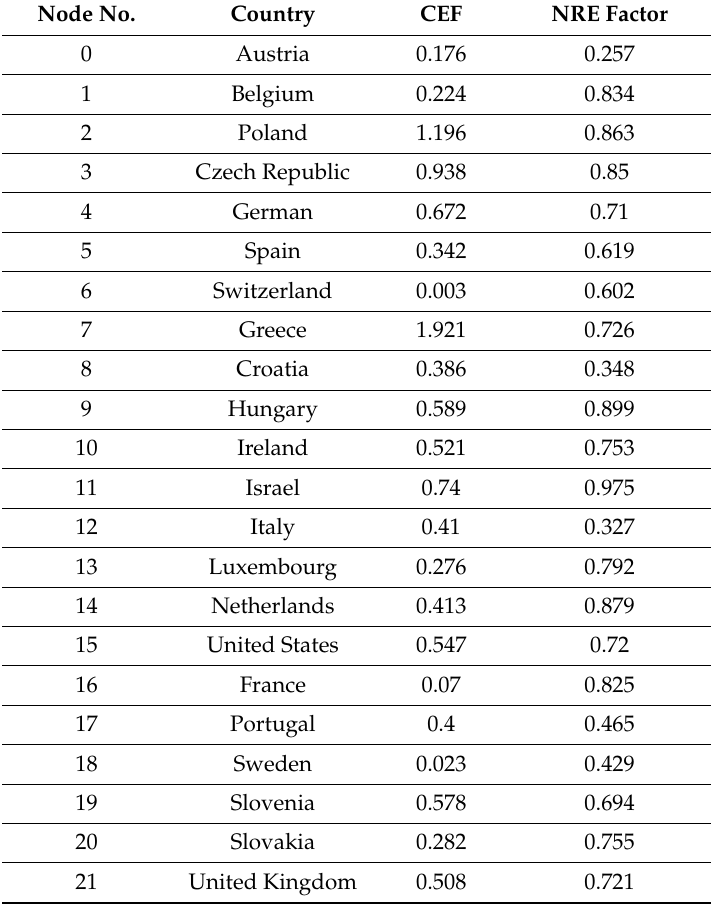
Table A2. List of nodes of the GEANT network with carbon and non-renewable energy factors. Node No. Country CEF NRE Factor 0